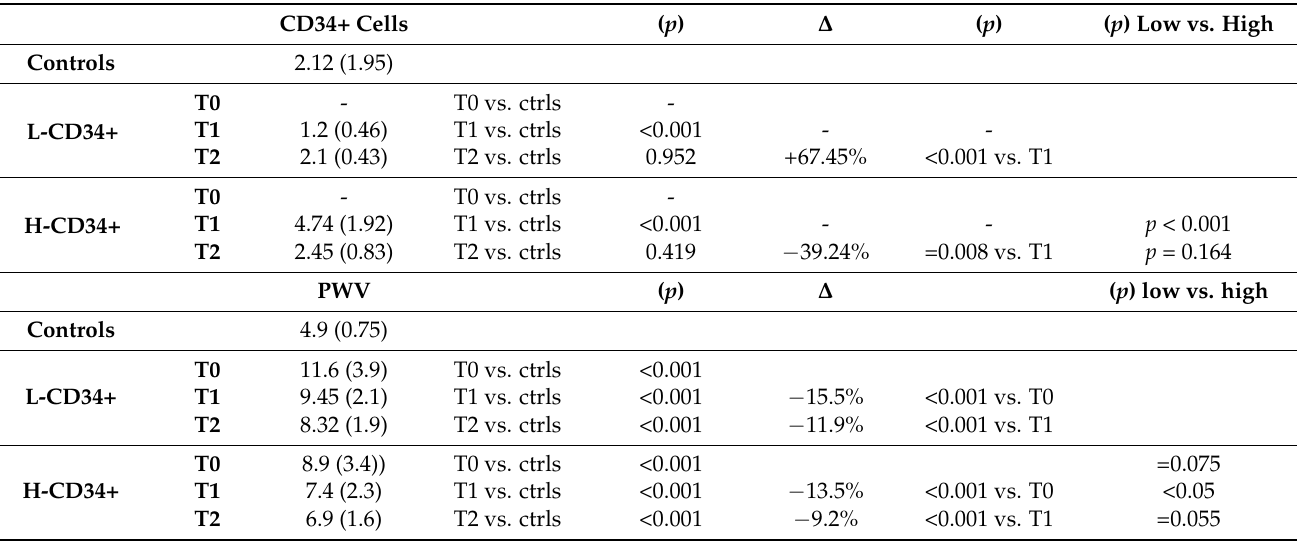
Table 4. Analysis of change in CD34+ cell number and PWV over time points in HeFH subjects as subdivided according to baseline CD34+ values.